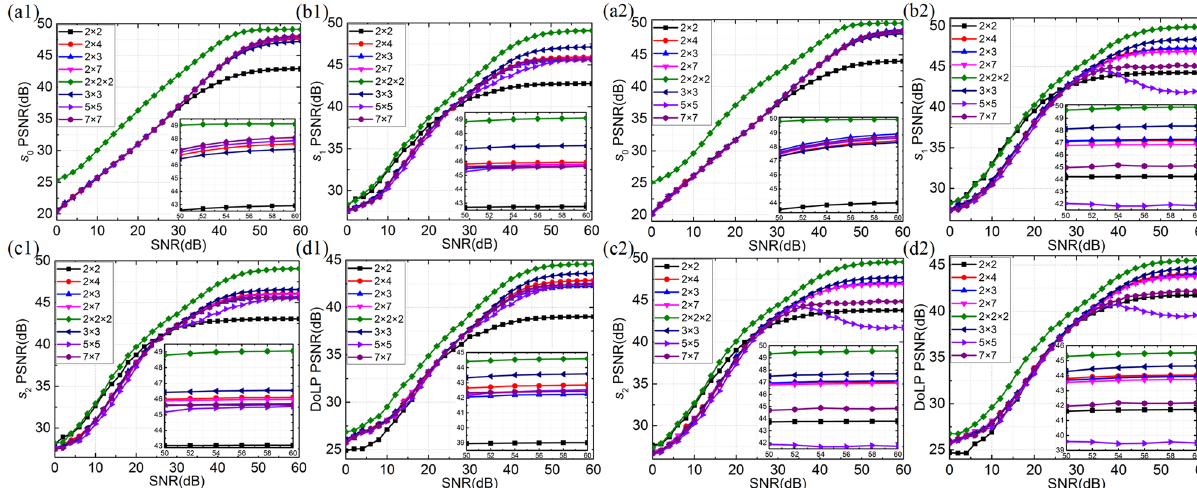
Figure 5. Convergent curves of the PSNR on the testing scenes with different MPA patterns. The left side on the building1 scene represents the ( a1 ) PSNR value of s 0 , ( b1 ) PSNR value of s 1 , ( c1 ) PSNR value of s 2 , ( d1 ) PSNR value of DoLP; the right side on the building2 scene represents the ( a2 ) PSNR value of s 0 , ( b2 ) PSNR value of s 1 , ( c2 ) PSNR value of s 2 , ( d2 ) PSNR value of